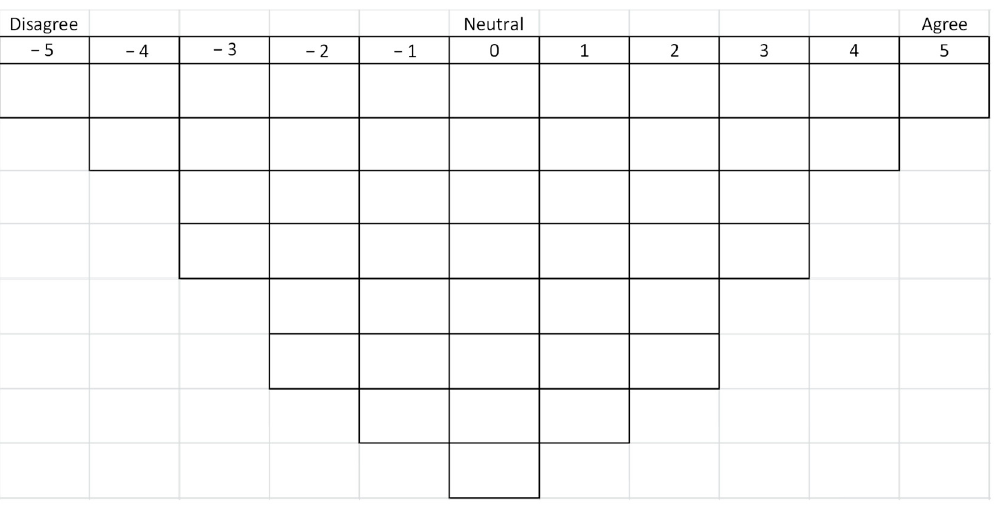
Figure 1. Score sheet for filling in Q-set.